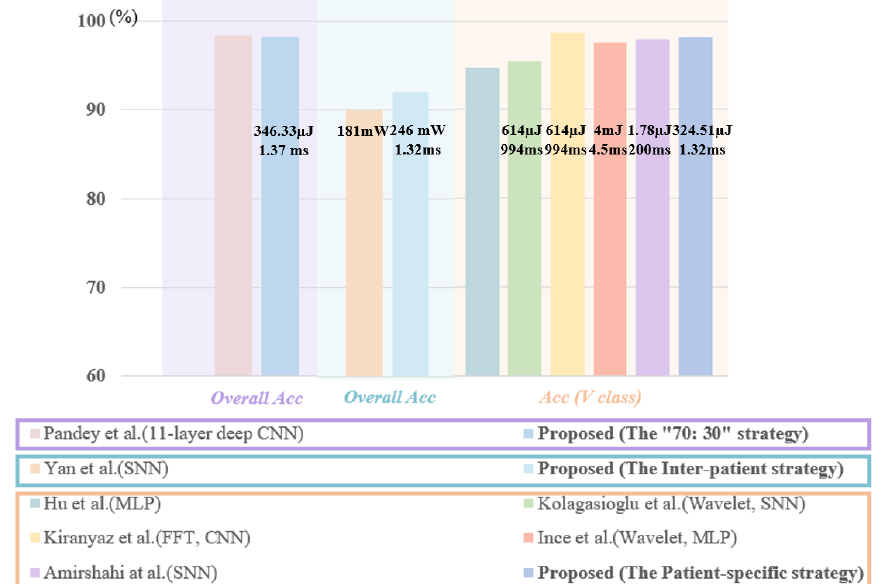
Figure 10. The performance comparison with other methods adopting the “70:30” strategy, Inter- patient strategy, and Patient-specific